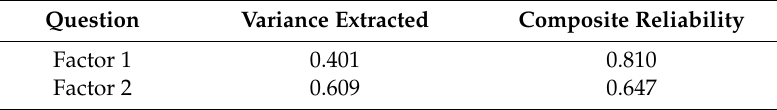
Table 8. Reliability of the measurement